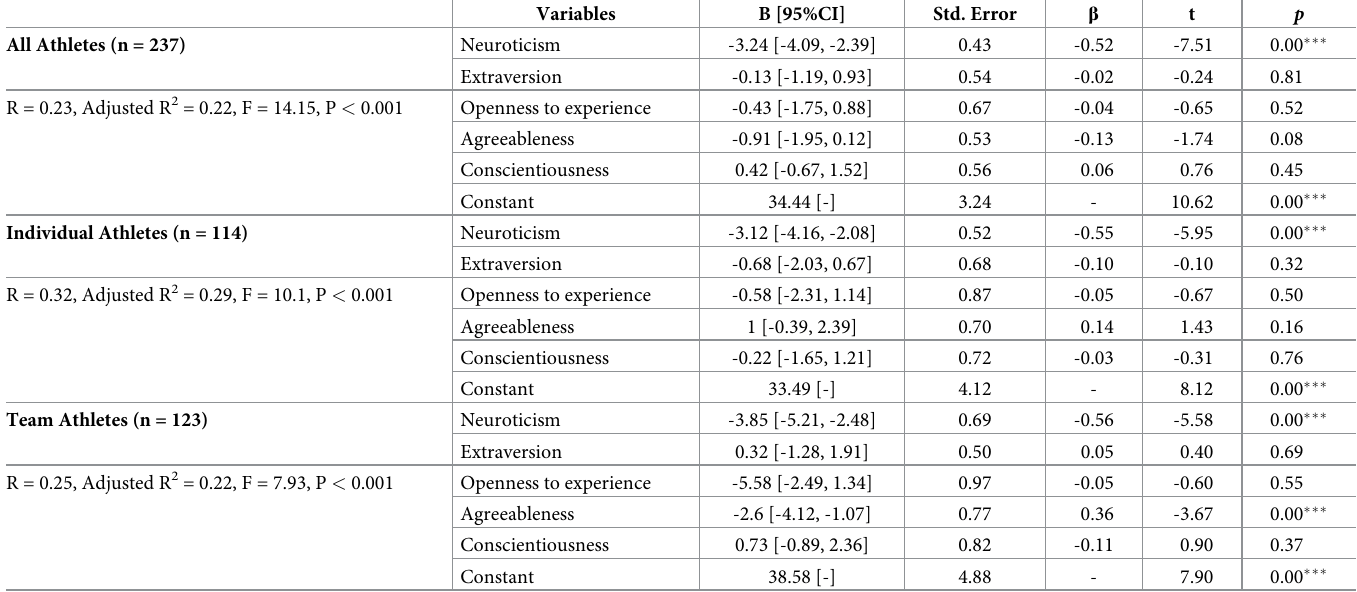
Table 3. Multiple linear regression analyzes in all athletes and different types of